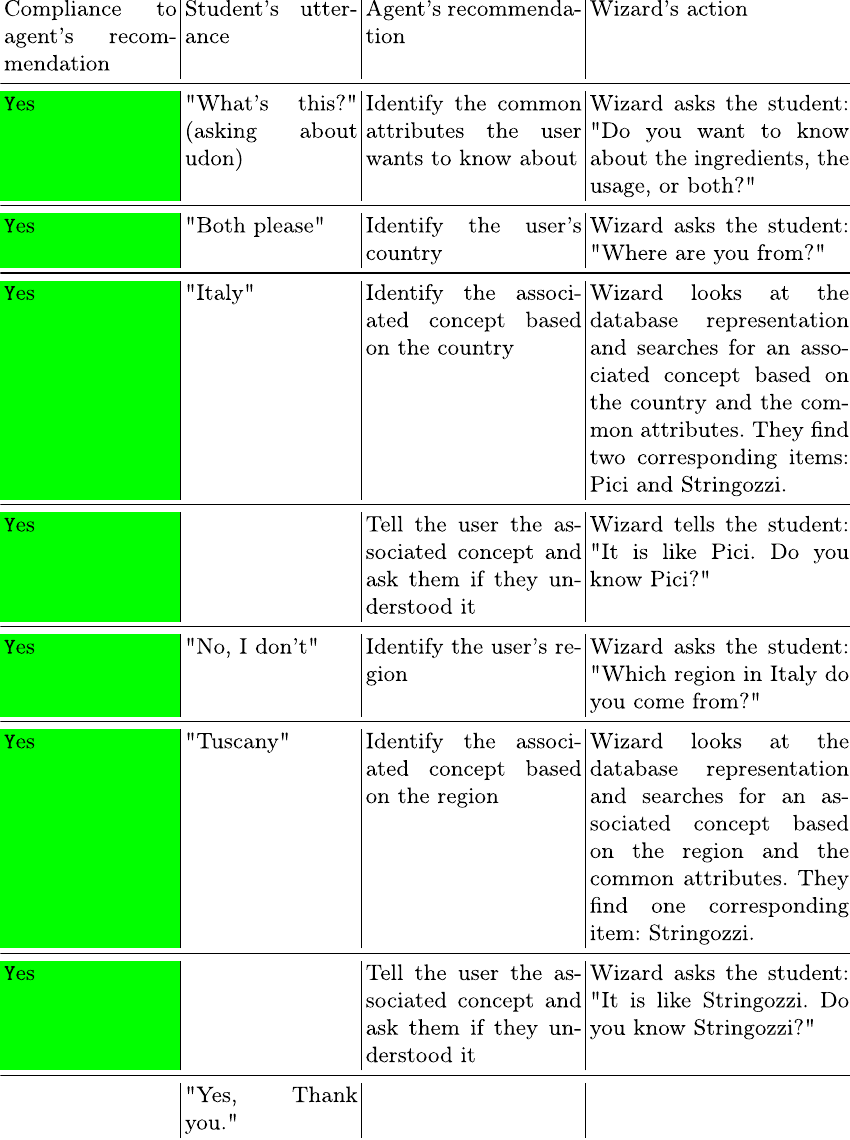
Table 5 Dialogue between the wizard and the intermediate agent and wizard’s compliance to recommendations